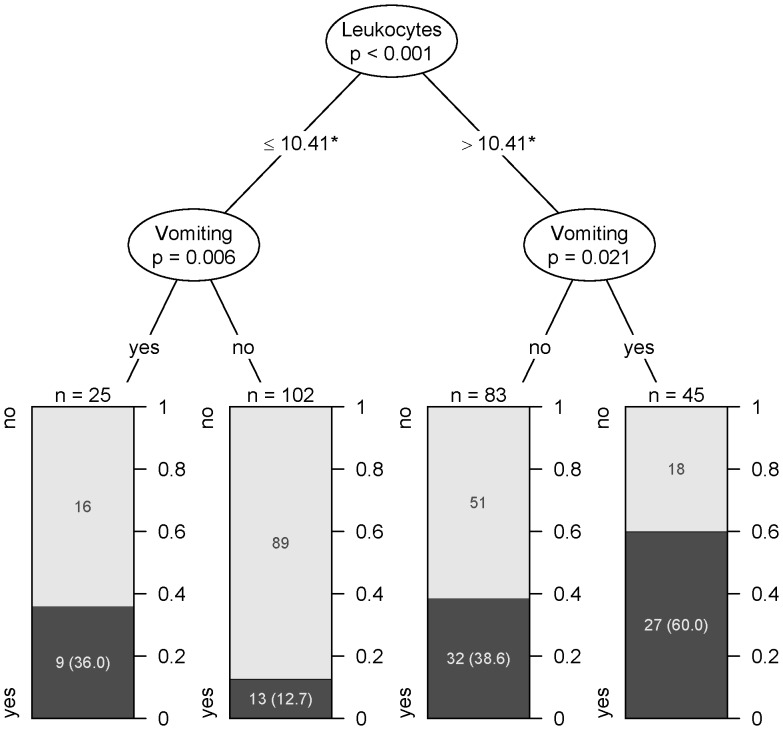
Decision tree allowing classification of patients with HUS (dark) and without HUS (bright).* cells /cubic mm.